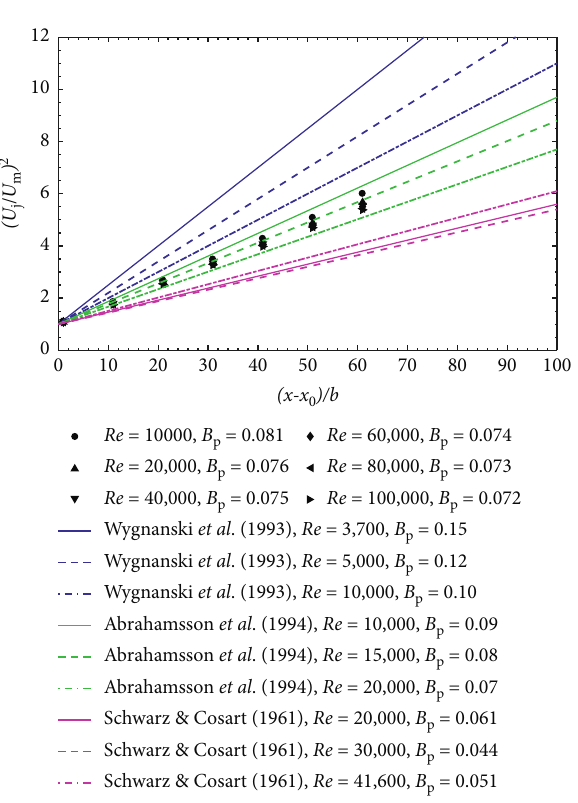
1/2 for various velocity